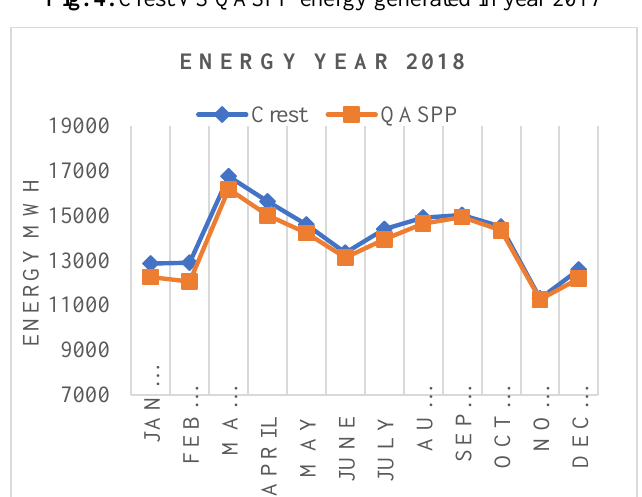
Fig. 4. Crest VS QASPP energy generated in year 2017